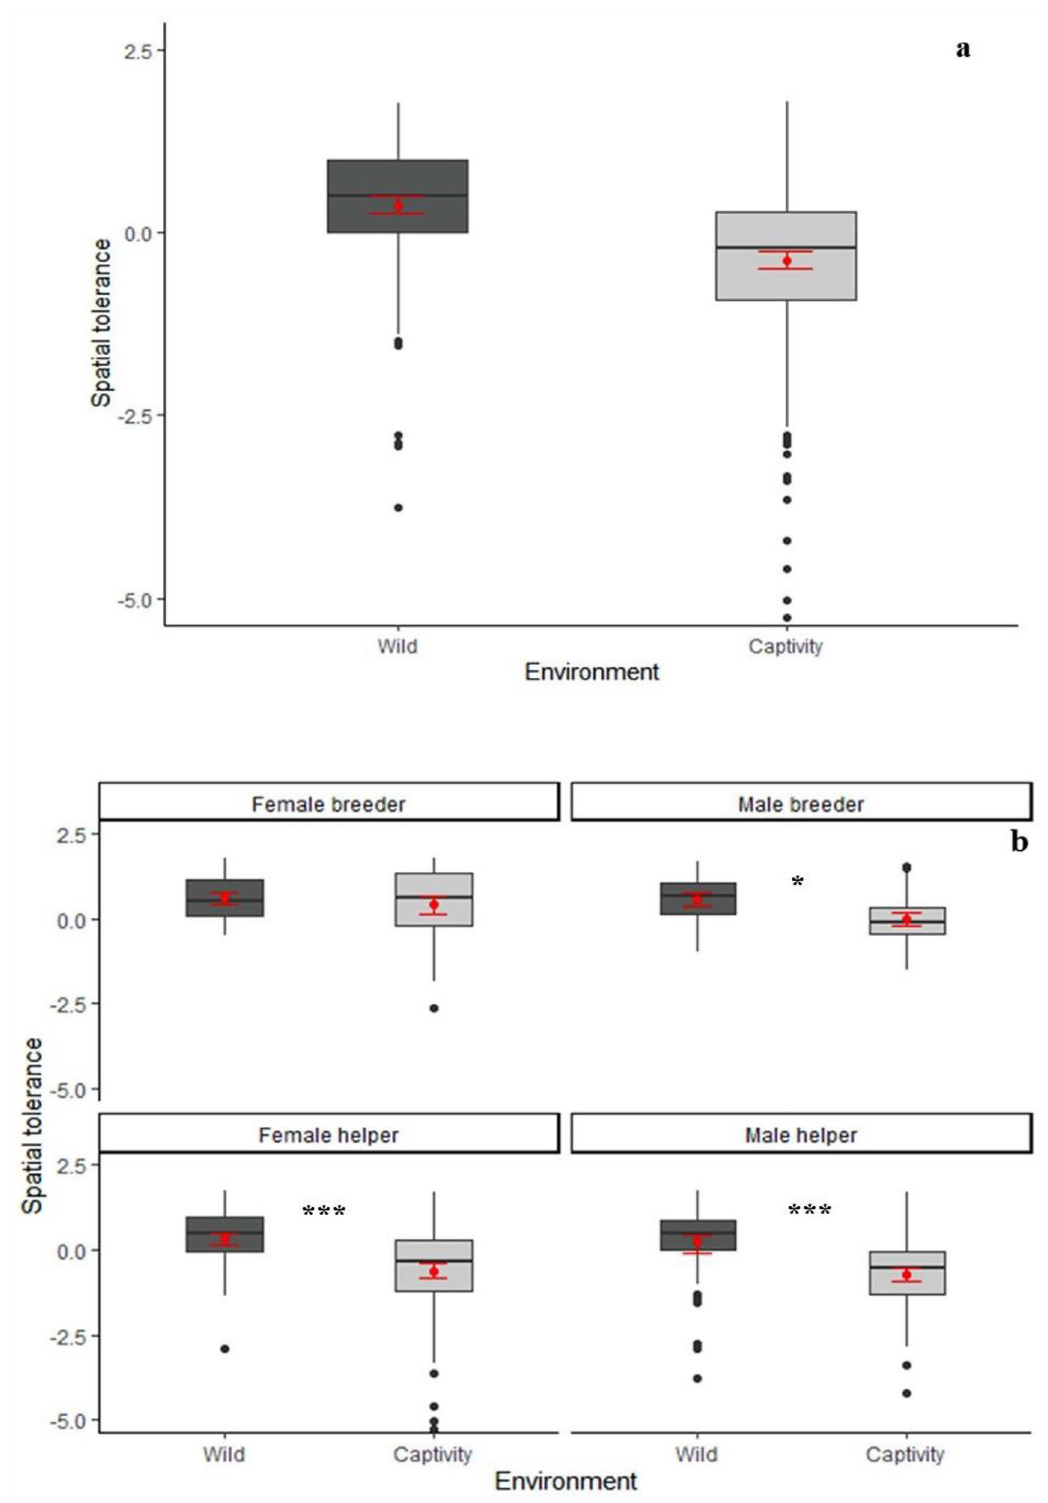
Figure 1. Spatial tolerance (PC1), split up according to ( a ) environment and ( b ) sex-status categories. * p < 0.05, ** p < 0.01, *** p < 0.001, (Games-Howell post-hoc tests). Black lines indicate medians; upper and lower edges of boxes indicate upper and lower quartiles; whiskers indicate the ranges for the bottom and top 25% of the data values, excluding outliers; black dots indicate outliers; red dots indicate mean value and red bars indicate SEM (N = 46). Software R Studio version 1.1.463. https ://www.r-proje